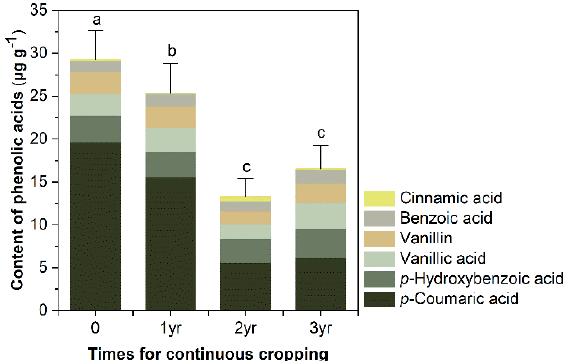
Figure 1. Content of phenolic acids extracted from soils with different monoculture history of Amer- ican ginseng. 0 yr: no growing history, 1 yr: 1-year monoculture, 2 yr: 2-year monoculture, 3 yr: 3-year monoculture. Bars: standard error of the mean (n = 3); different letters and the asterisk indicate significant differences in total concentration according to one-way ANOVA analysis ( p < 0.05). The detailed information of the ANOVA results are shown in Table A1.